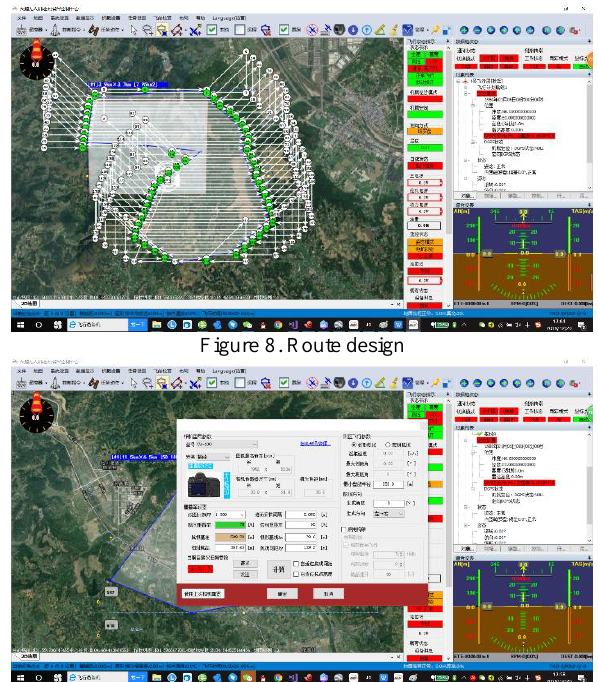
Figure 9. The intelligent planning function setting interface